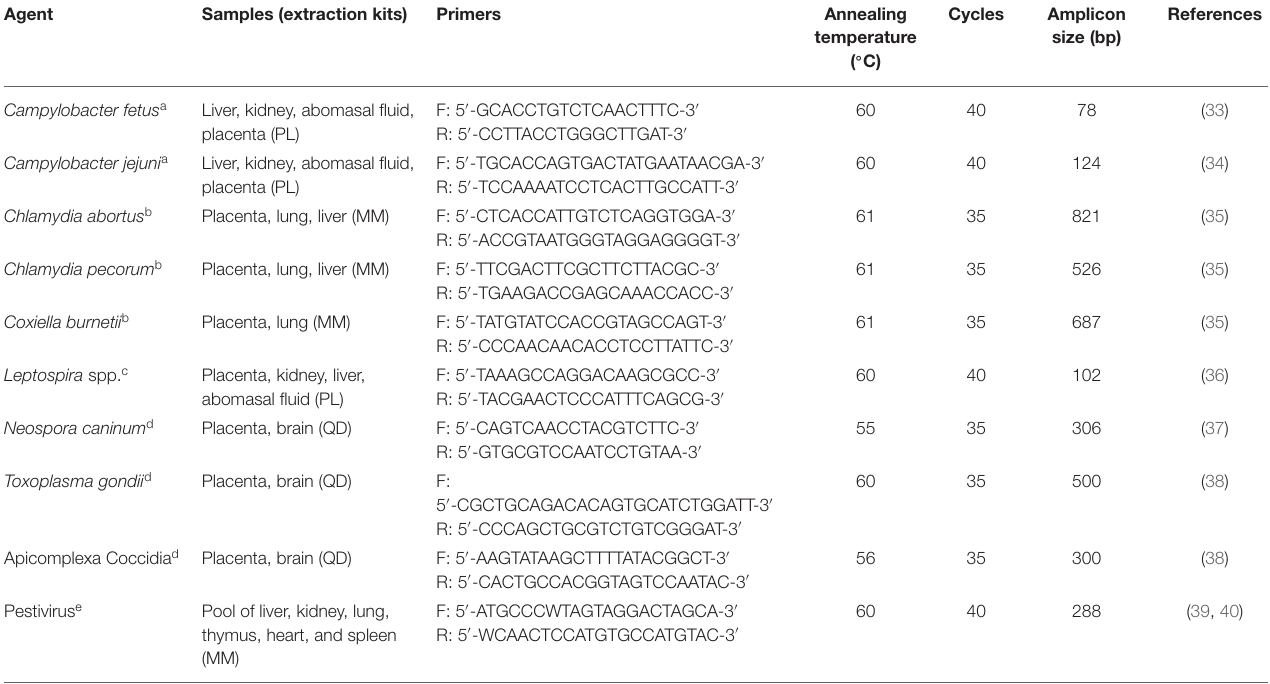
TABLE 1 | Samples, nucleic acid extraction kits, primers, and reaction conditions used for the PCR protocols for the detection of bacterial, protozoal, and viral pathogens in cases of ovine abortion.